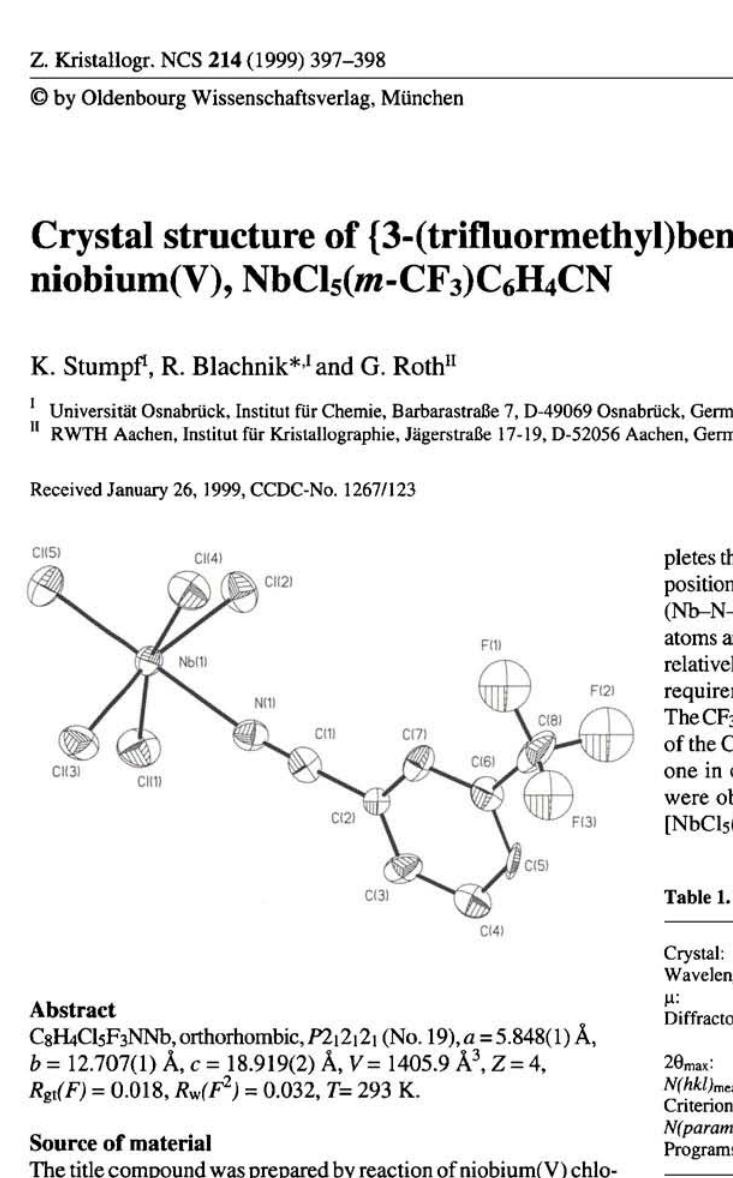
Table 1. Data collection and handling.